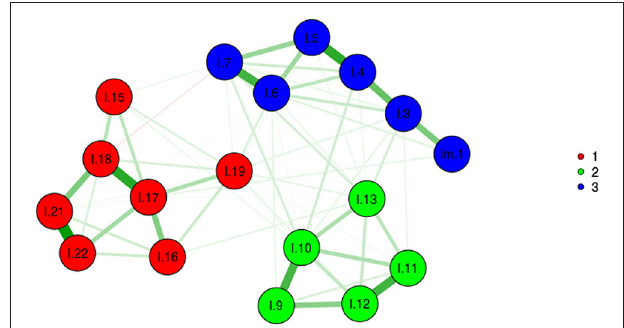
TABLE 1 | Demographic characteristics of participants ( n